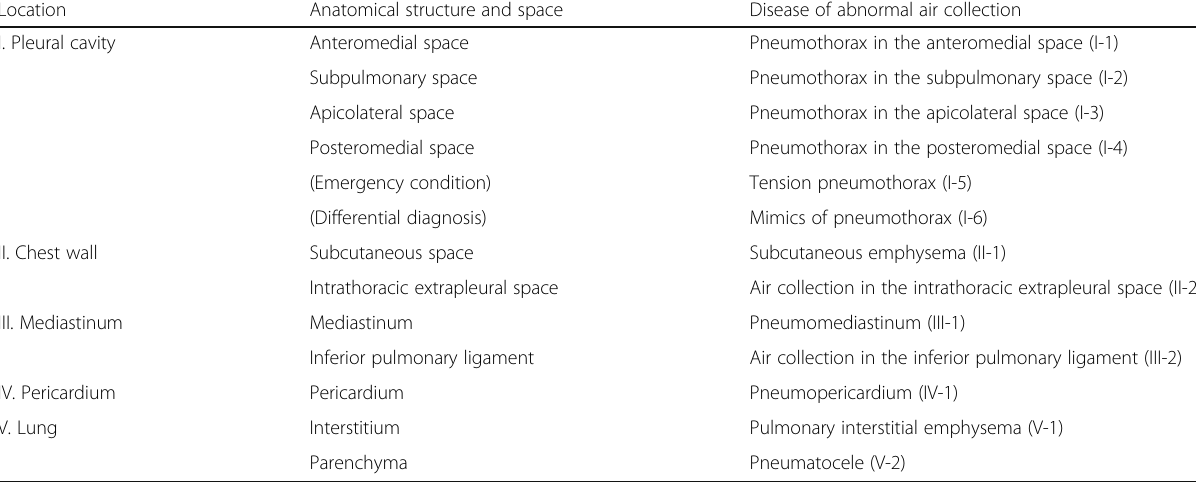
Table 1 Classification of thoracic abnormal air collection based on anatomy Location Anatomical structure and